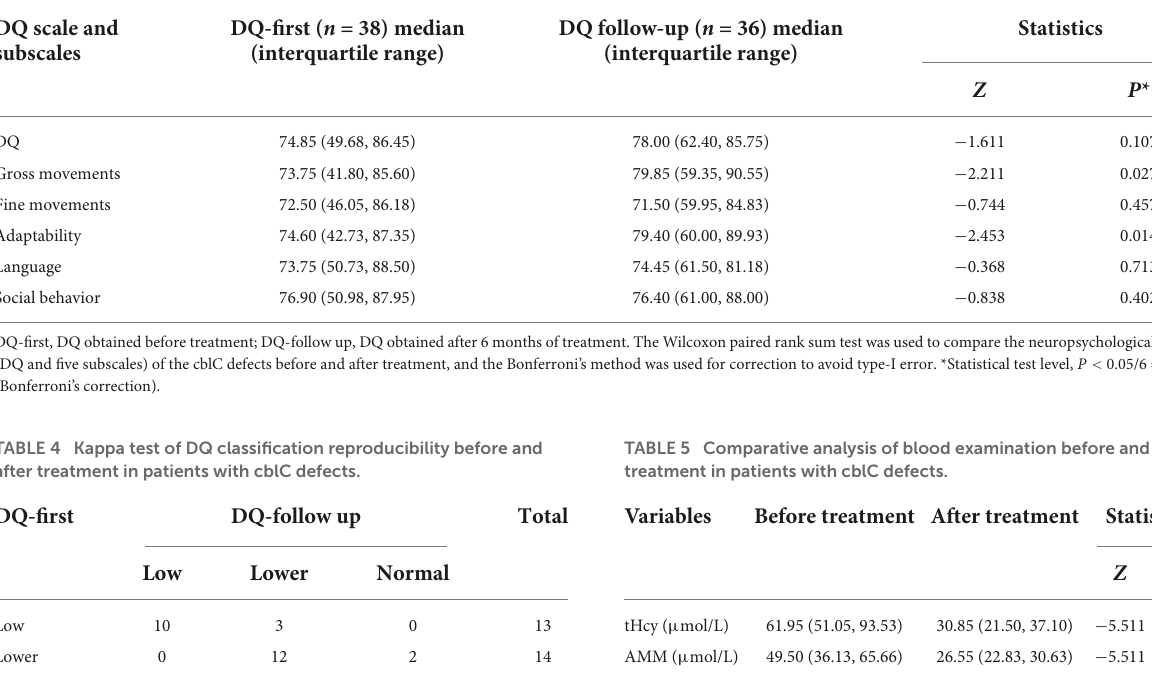
TABLE 3 Comparative analysis of DQ before and after treatment in patients with cblC defects.